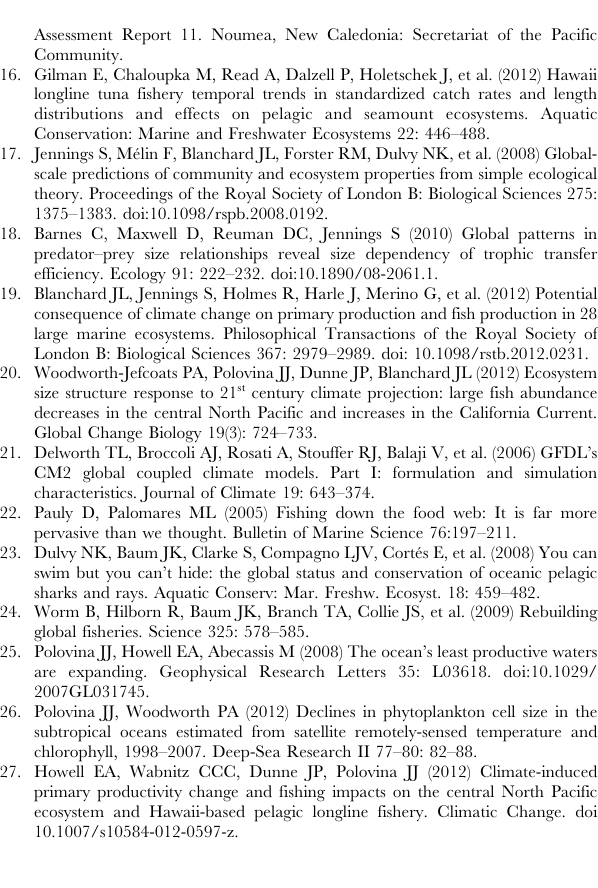
Figure S1 The annual logbook and generalized additive model CPUE ( # fish per 1000 hooks). Panels indicate ( A ) fishes , 15 kg and ( B ) fishes $ 15 kg. In both panels black line represents CPUE from logbook data, blue line represents CPUE estimated from the generalized additive model. Table S1 Mean species weight, length, and length-weight conversion factors. From left, columns indicate species, mean species weight as determined form length-weight conversions, mean length from those recorded by observers measuring every third fish from 2006–2011, a , b , and reference listing length-weight